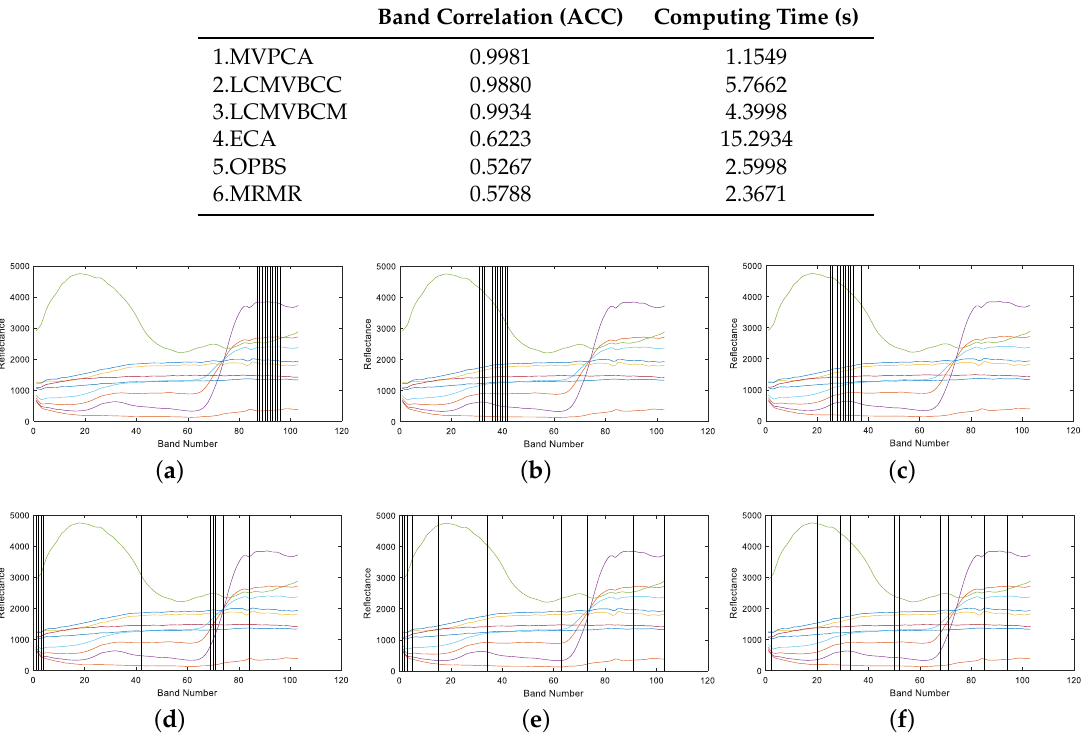
Figure 12. Spectrums of the categories on the Pavia University dataset. The straight lines denote the bands selected by different BS methods. ( a ) MVPCA ( b ) LCMVBCC ( c ) LCMVBCM ( d ) ECA ( e ) OPBS ( f )